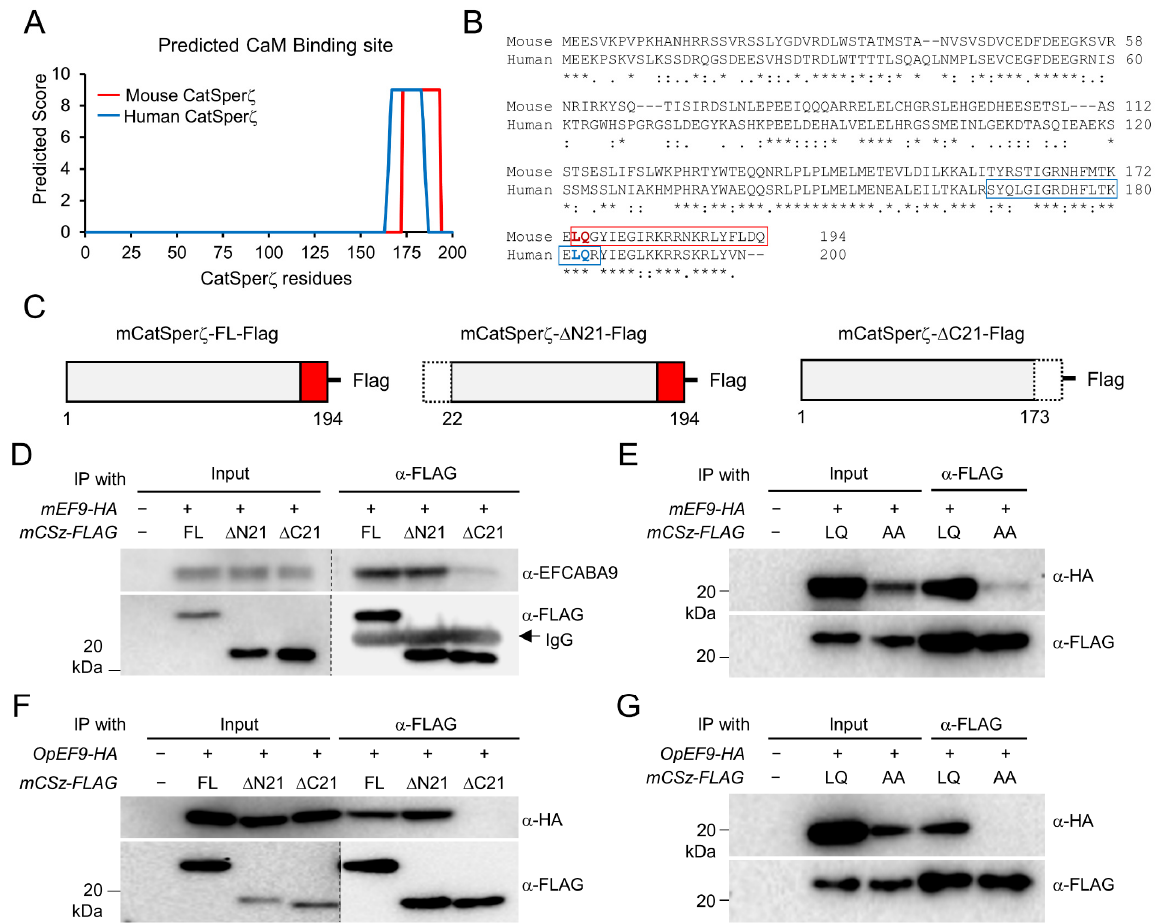
Figure 6. The IQ-like motif in the C-terminal CatSper ζ is crucial for CatSper ζ -EFCAB9 interaction conserved in placental mammals. ( A , B ) A putative calmodulin (CaM)-binding site conserved in mouse and human CatSper ζ . ( A ) The predicted CaM-binding site in mouse (red) and human (blue) CatSper ζ were scored and plotted. ( B ) Pair-wise sequence alignment of human and mouse CatSper ζ proteins. The predicted CaM-binding sites are boxed. L174Q175 residues (bolded) in the CaM-binding regions are conserved in human and mouse CatSper ζ . ( C ) Schematic diagrams of recombinant mouse CatSper ζ (mCatSper ζ ) in full-length (right, FL; 1-194 aa) or 21-residue truncation at N-terminus (middle, ∆ N21; 22-194 aa) or C-terminus (right, ∆ C21; 1-173 aa). The candidate CaM-binding sites are red-boxed. ( D – G ) Co-immunoprecipitation of mouse CatSperz with defective IQ-like motif and mouse ( D , E ) or opossum EFCAB9 ( F , G ) in a heterologous system. Mouse CatSperz ( mCSz-FLAG ) with N- (DN21) or C- (DC21) termini truncation ( D , F ) or sequence mutation at IQ-like motif (L174A/Q175A, AA; E , G ) were transiently expressed in 293T cells together with mouse ( mEF9-HA ) or opossum ( OpEF9-HA ) EFCAB9 in 293T cells and co-immunoprecipitated.